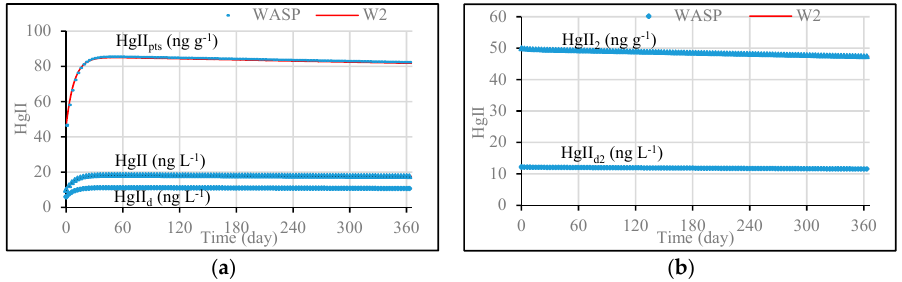
Hg0 oxidation, HgII reduction, HgII methylation and sediment-water transfer rates were relatively small. Total concentration of HgII in the sediment layer was more stable for the simulation period. The sediment layer become a large storage reservoir for Hg.